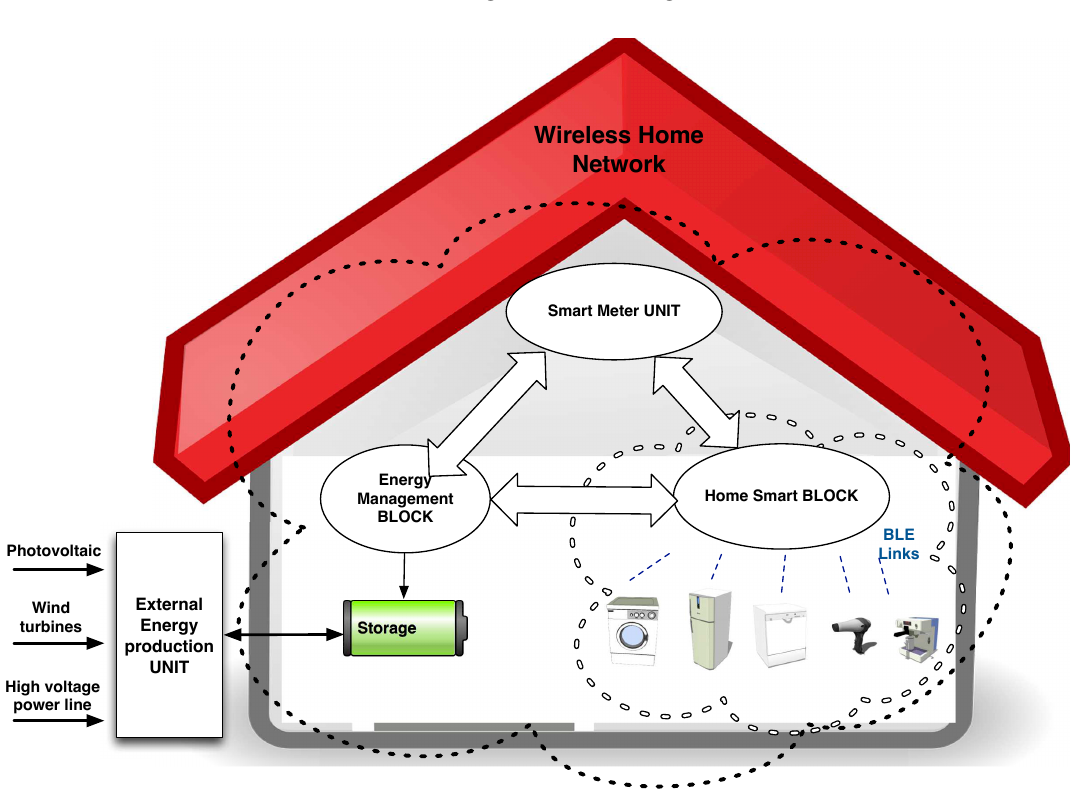
Figure 1. The proposed energy management system for smart